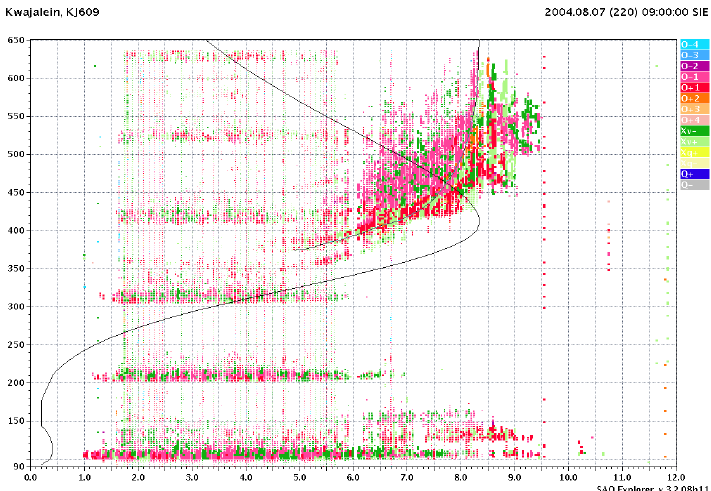
Fig. 3. Kwajalein ionogram from 7 August 2004, 09:00 UT. The vertical axis is range delay in km, and the horizontal axis is plasma frequency in MHz. Ordinary and extraordinary mode echoes are shown in red and green. The virtual height trace and derived electron density profile are shown as black lines. Intense sporadic E layers mask the F layer below 5MHz. The F layer peak is visible and shows signs of both range and frequency type spread developing. Multiple colors in the spread trace represent a wide range of observed Doppler shifts.